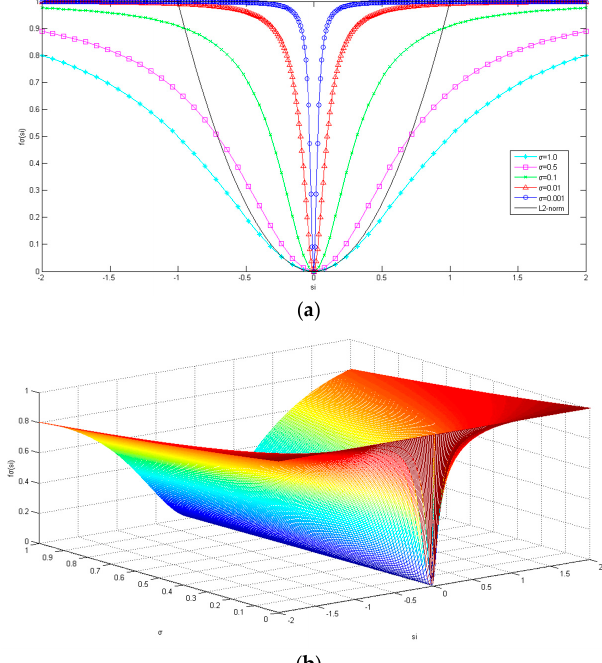
Figure 2. ( a ) A 1D example of f σ ( s i ) with different σ values. The L 2 norm of the black solid line is included for comparison. ( b ) A 2D example surface plot of f σ ( s i ) .